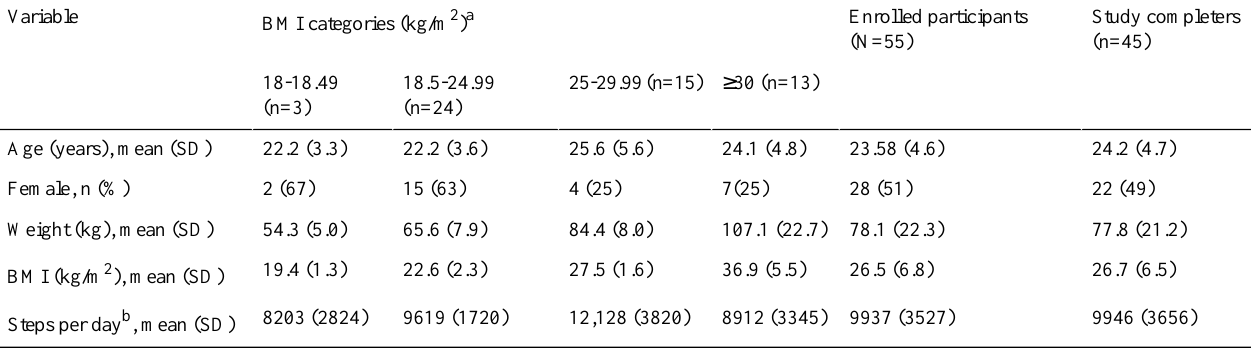
Table 1. Baseline characteristics of the study sample, according to BMI